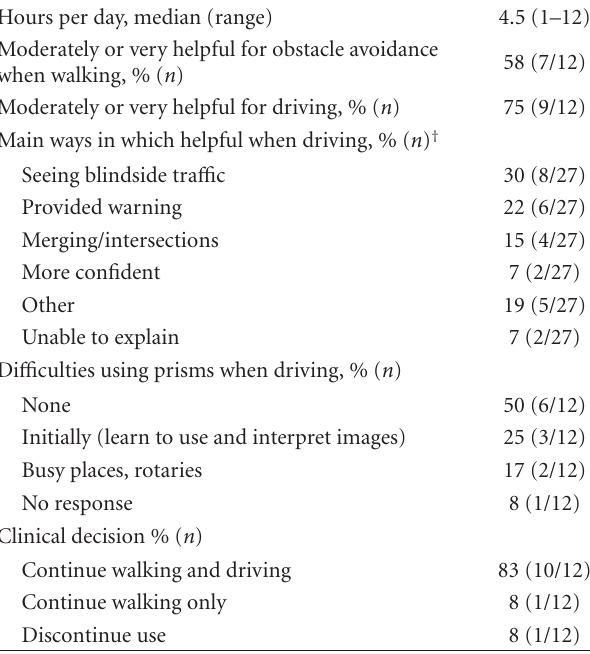
Table 4: Participants’ experiences of using real prism glasses and clinical